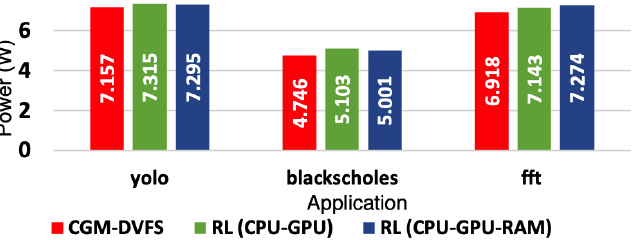
Figure 2. Average power consumption (Watts) when executing different benchmark applications using different